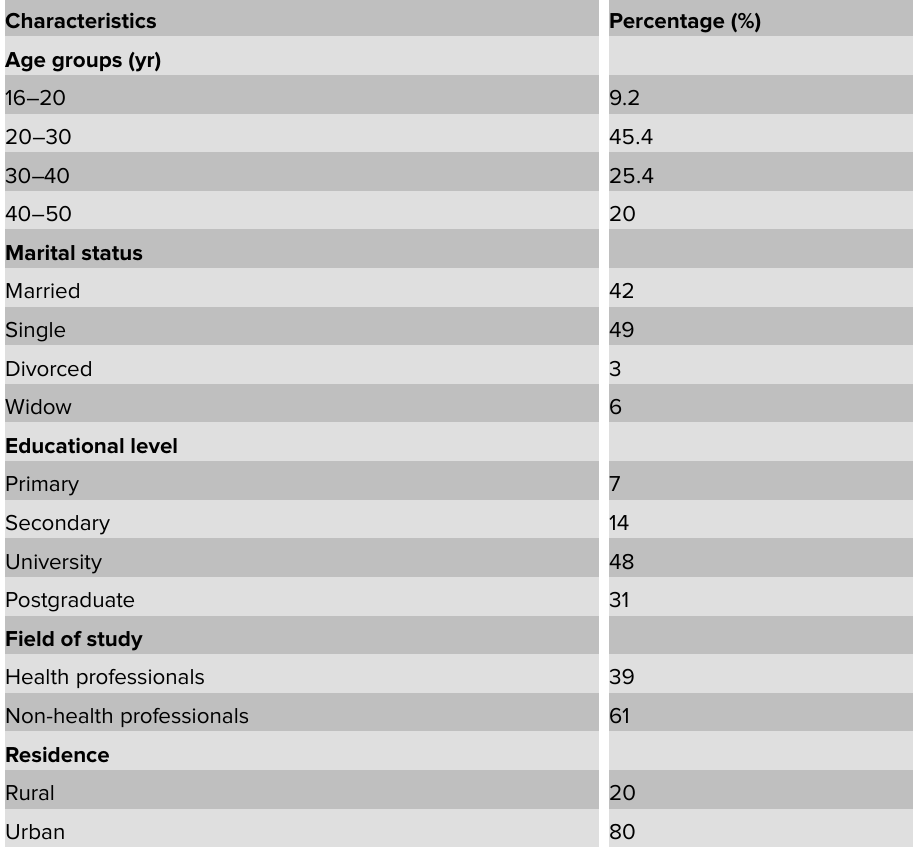
Table 1: Sociodemographic characteristics among studied population ( n =